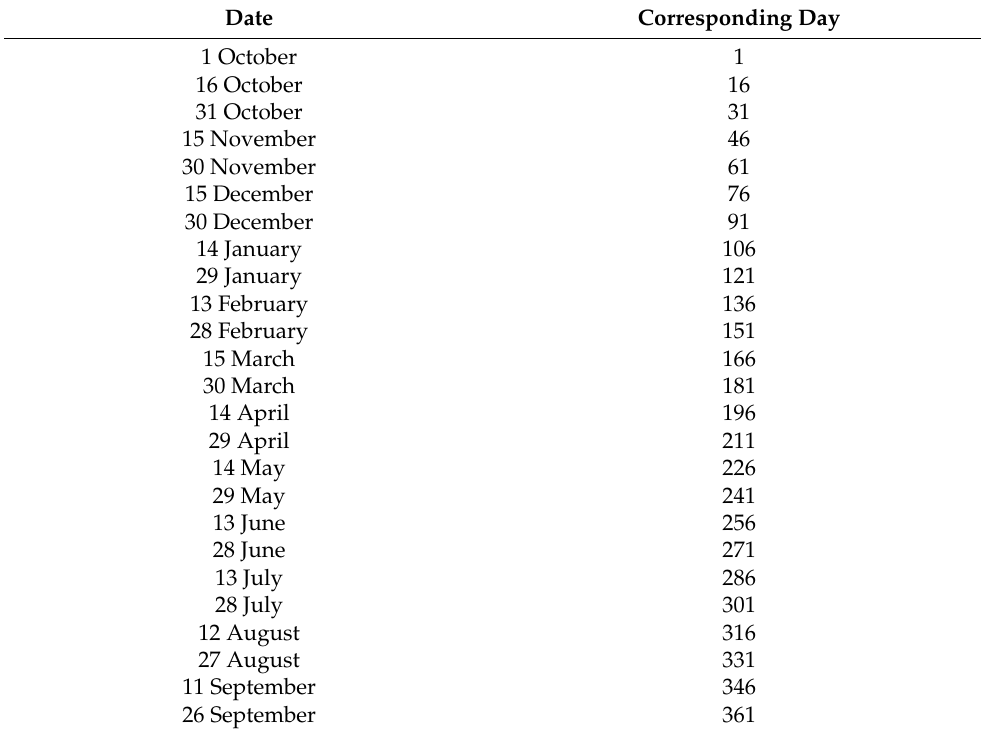
Table 1. Correspondence between the day of the hydrological year and calendar date for the grid points with continuous snow